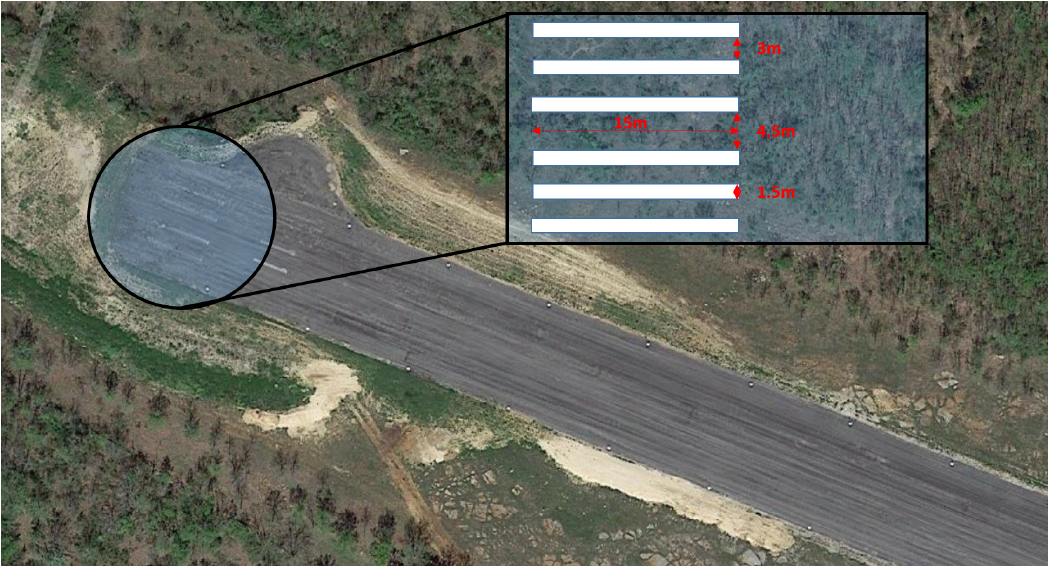
Figure 10. Septfonds private airfield is perfect for fixed-wing UAV prototype testing; however, its original painting was not sufficient for visual navigation. Septfonds runway with the PVC markers can be seen in Figure 2.